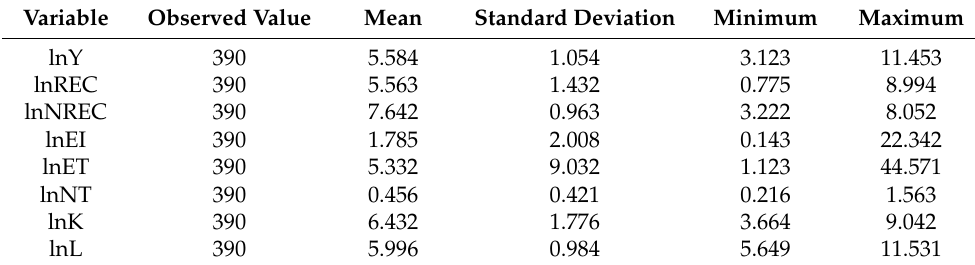
Table 2. Descriptive statistics of variables.